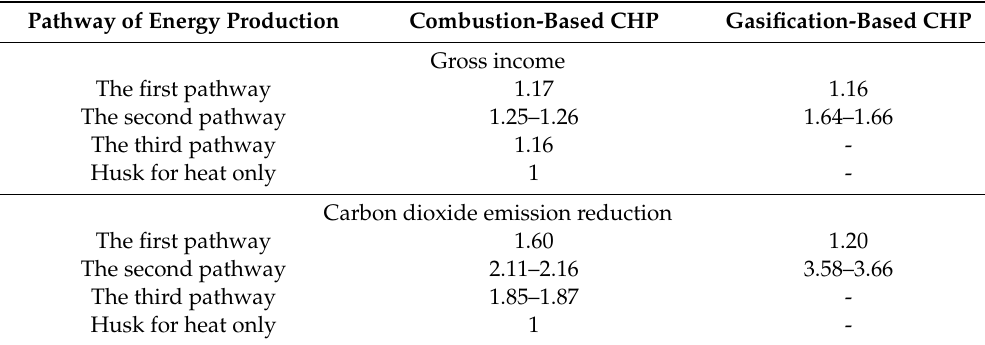
Table 3. Relative gross income and carbon dioxide emission reduction.